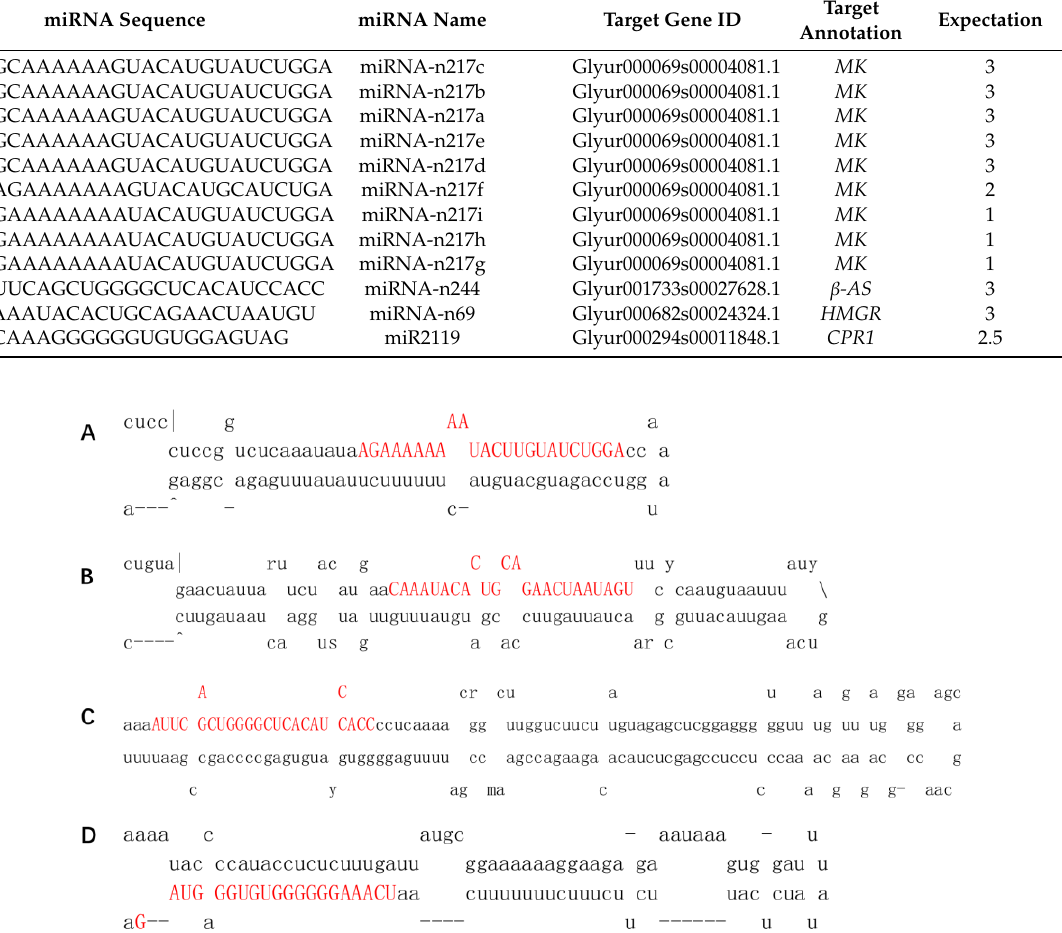
Figure 6. Precursor structure of miRNA-n217g ( A ), miRNA-n244 ( B ), miRNA-n69 ( C ), and miR2119 ( D ). The red capitalized bases represent the sequences of mature miRNA.